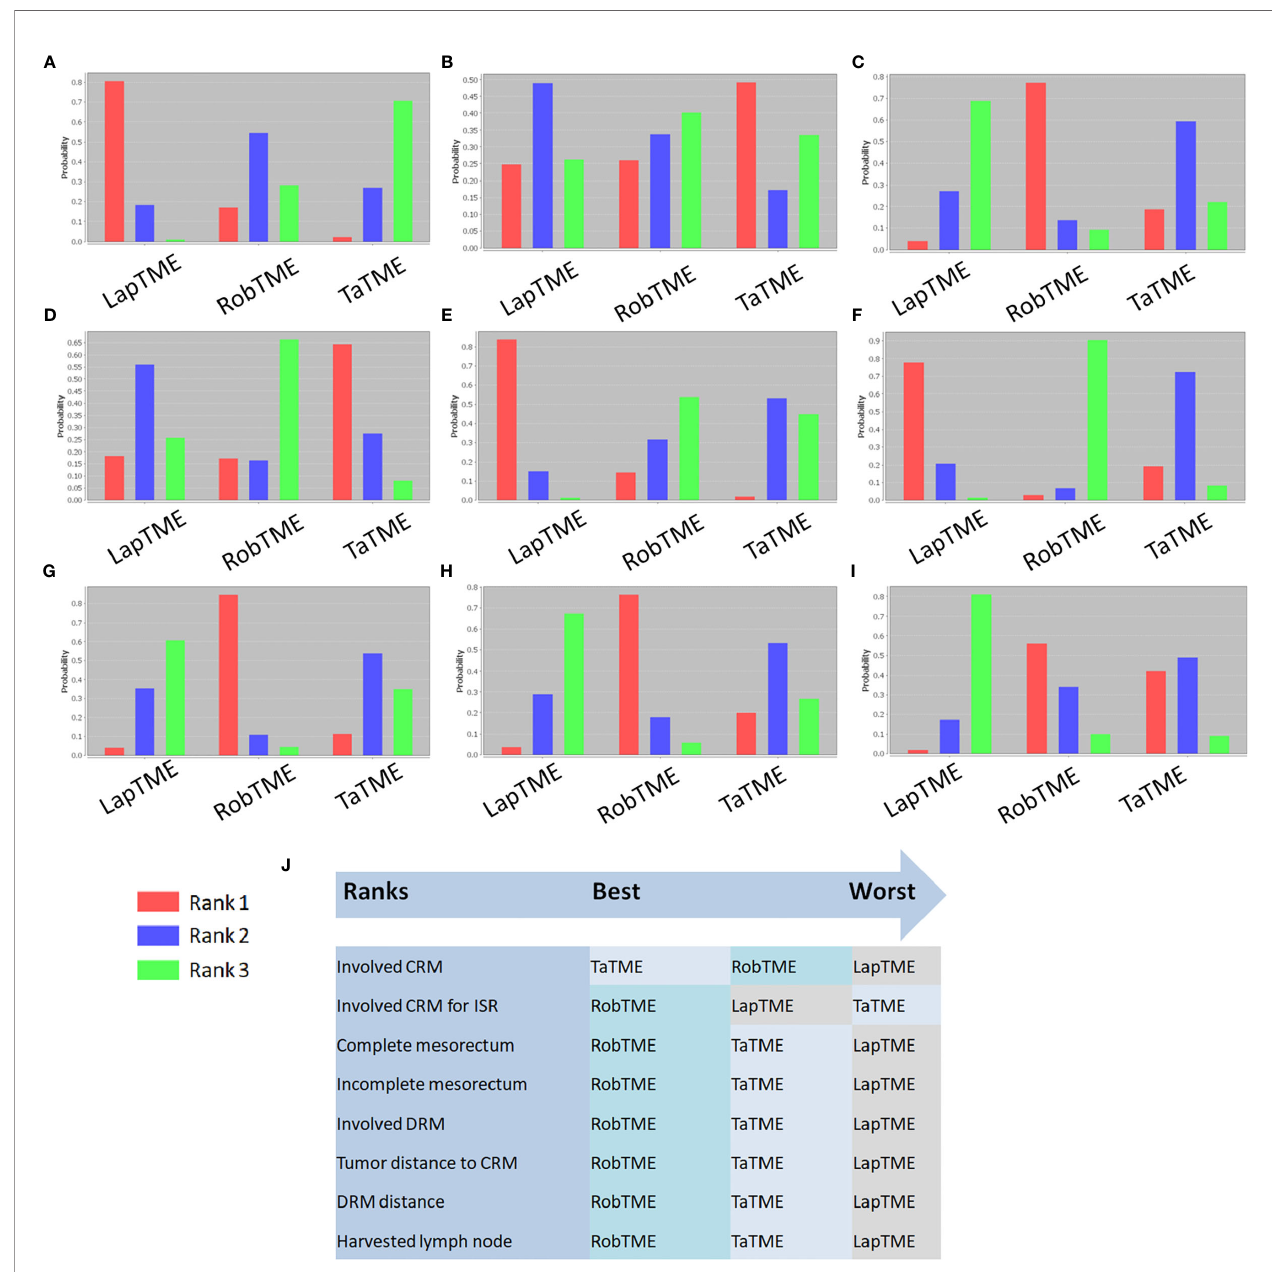
FIGURE 3 | Rank probability diagram. (A) CRM involvement; (B) CRM involvement for ISR; (C) Complete mesorectum; (D) Near complete mesorectum; (E) Incomplete mesorectum; (F) DRM involvement; (G) Tumor distance to the CRM; (H) DRM distance; (I) Harvested lymph nodes; (J) Summary of surgical approach rank in terms of surgical resection